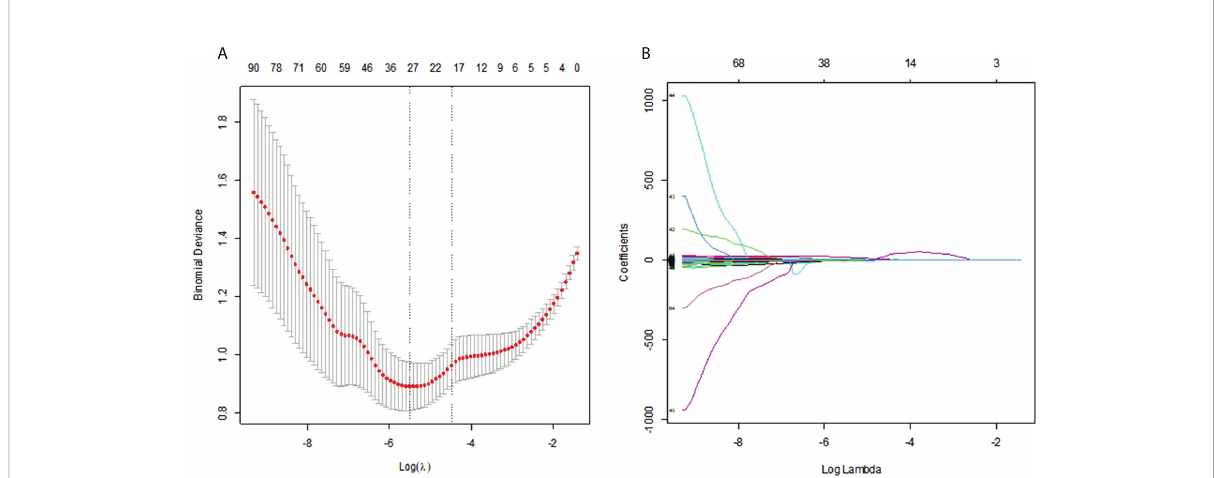
FIGURE 4 (A) Selection of the tuning parameter l in the LASSO model via 10-fold cross-validation was based on the 1 standard error of the minimum criteria (the 1 − SE criteria). The value of l that gave the minimum average binomial deviance was used to select features. Dotted vertical lines were drawn at the optimal values using the minimum criteria and the 1 − SE criteria. (B) LASSO coef fi cient pro fi les of the 112 radiomics features. A vertical line was drawn at the value selected using 10-fold cross-validation, where optimal result was 31 non-zero coef fi cients.